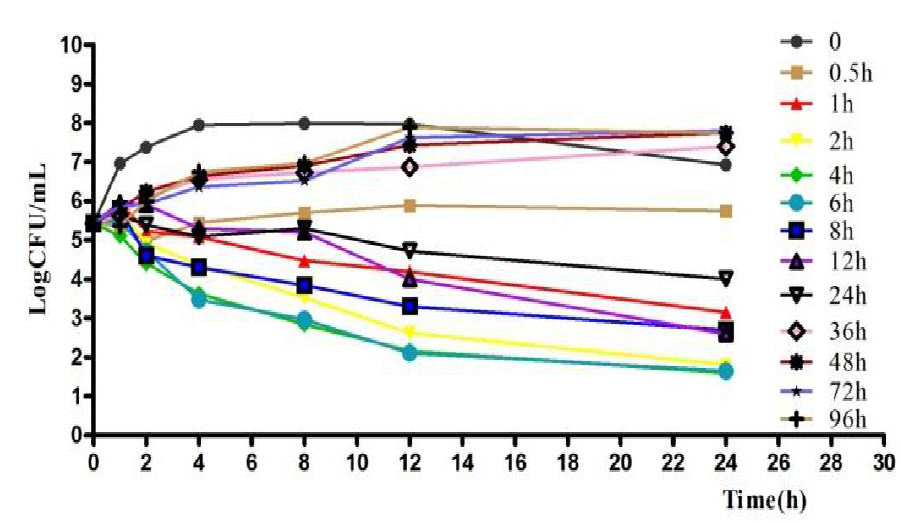
Figure 3. Ex vivo antibacterial activity of acetylkitasamycin in PELF of piglets against S. suis after intragastric administration.